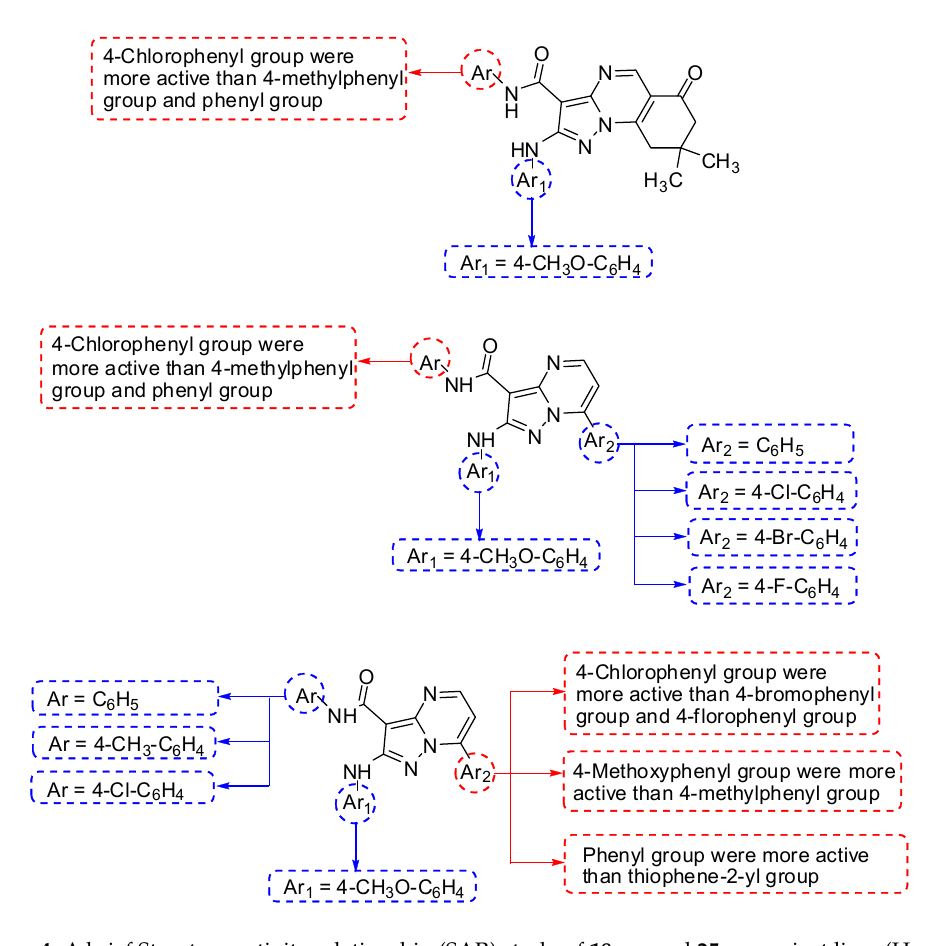
Figure 4. A brief Structure-activity relationship (SAR) study of 18a – u and 25a – c against liver (HepG2) cell lines. cell